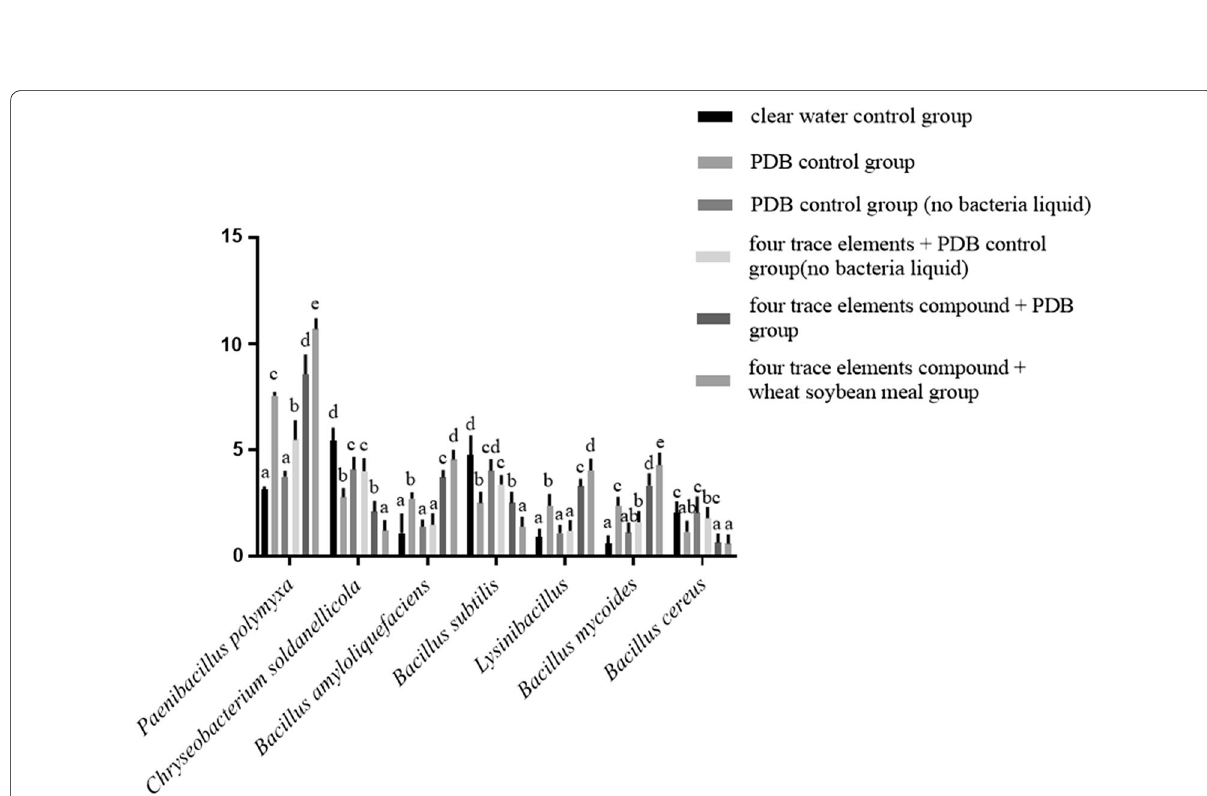
Fig. 7 Effect of trace elements on the rhizosphere bacterial community of